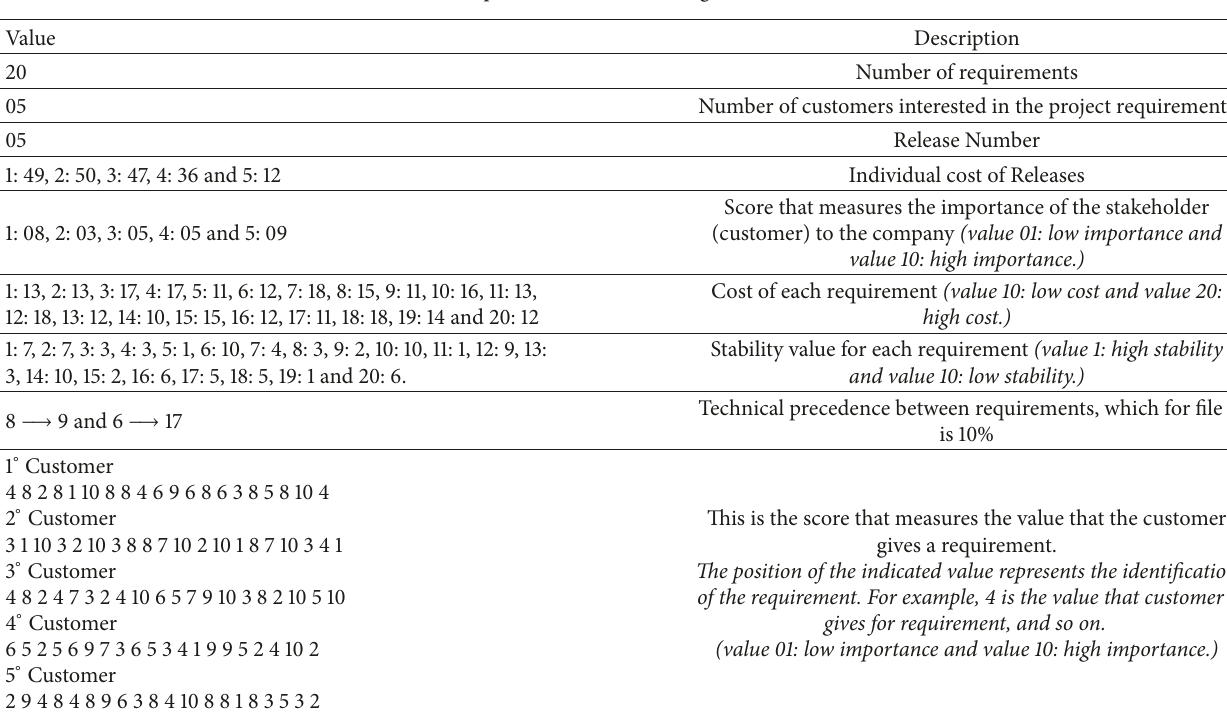
Table 2: Representation of the data generated for file